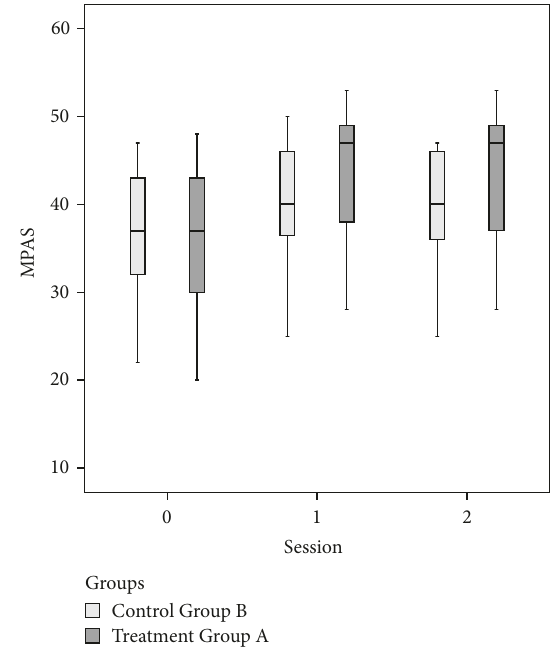
Figure 5: Modified Parkinson’s Activity Scale (MPAS) at baseline (= T 0) and at the end of the treatment (= T 1) and follow-up (= T 2) for the two